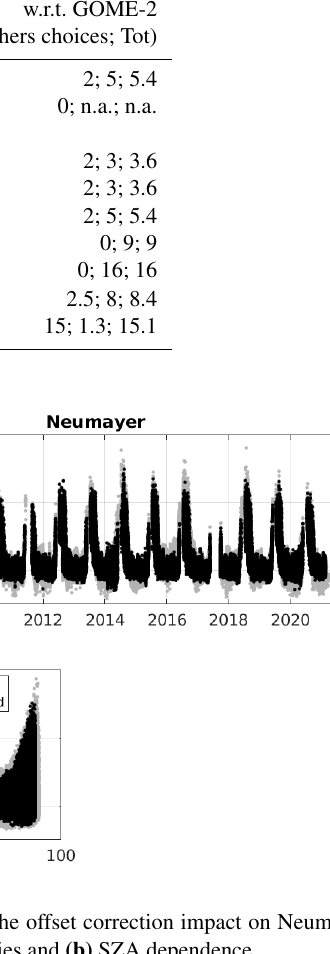
Figure 6. Illustration of the AMFs used for the Langley plots. The grey area indicates the range of the measured OClO AMFs, the red curve shows their median value, and the blue and green curves are AMFs calculated using the DISORT radiative transfer model cou- pled PSCBOX and initialized with SLIMCAT 3-D chemical trans- port model simulations.